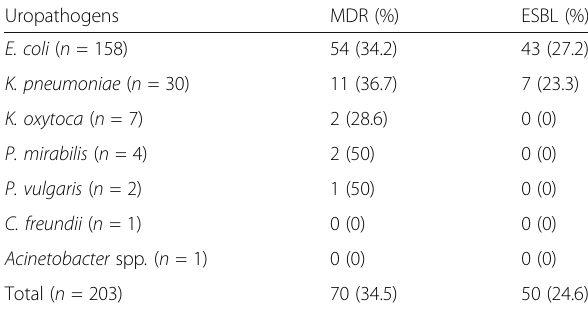
Table 3 Prevalence of MDR and ESBL-producing